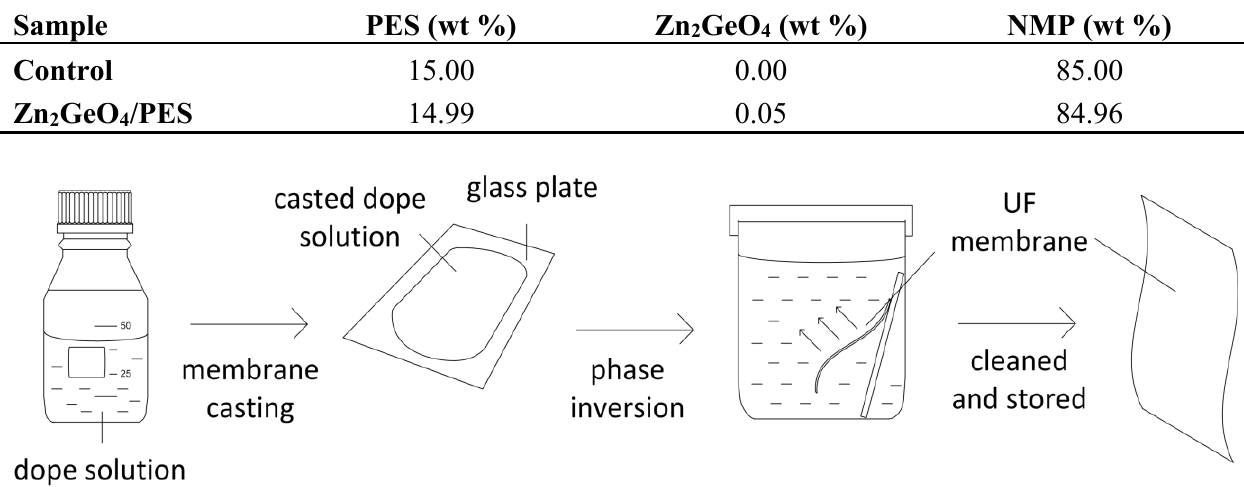
Figure 6. Schematic diagram of UF membrane fabrication via phase inversion.